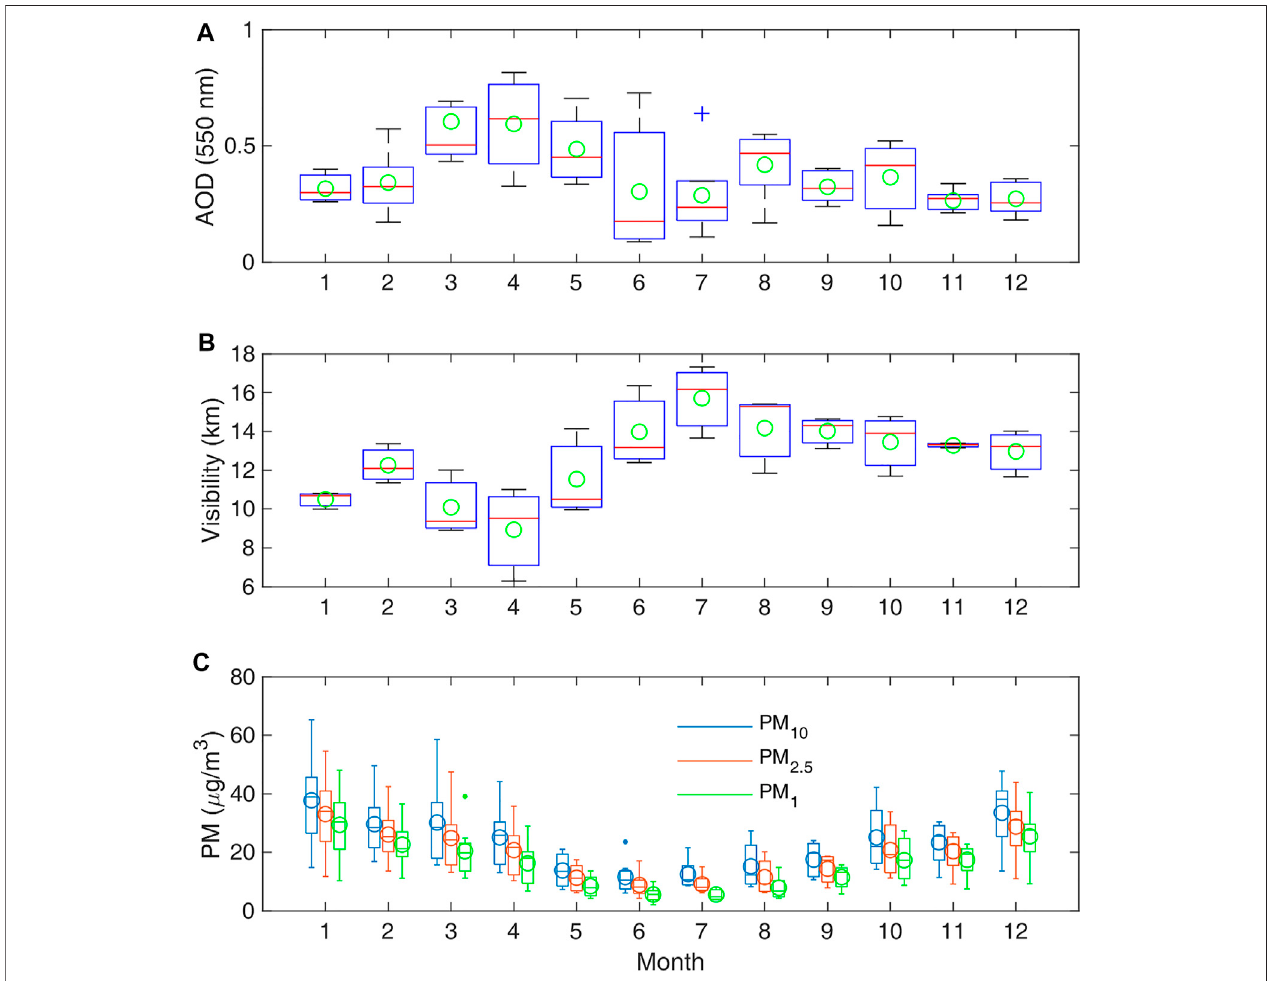
FIGURE 3 | Boxplot of monthly averaged AOD (A) from Jan. 2011 to Jun. 2017, visibility (B) from Jul. 2015 to Jun. 2018, and PM mass concentrations (C) from Jan. 2011toJun. 2018at Xichong. Theends ofthe boxes, the ends ofthewhiskers,and theshort lineacrosseach box representthe 25thand 75th percentiles,the 5th and 95th percentiles, and the median, respectively. The means are represented by the circles.